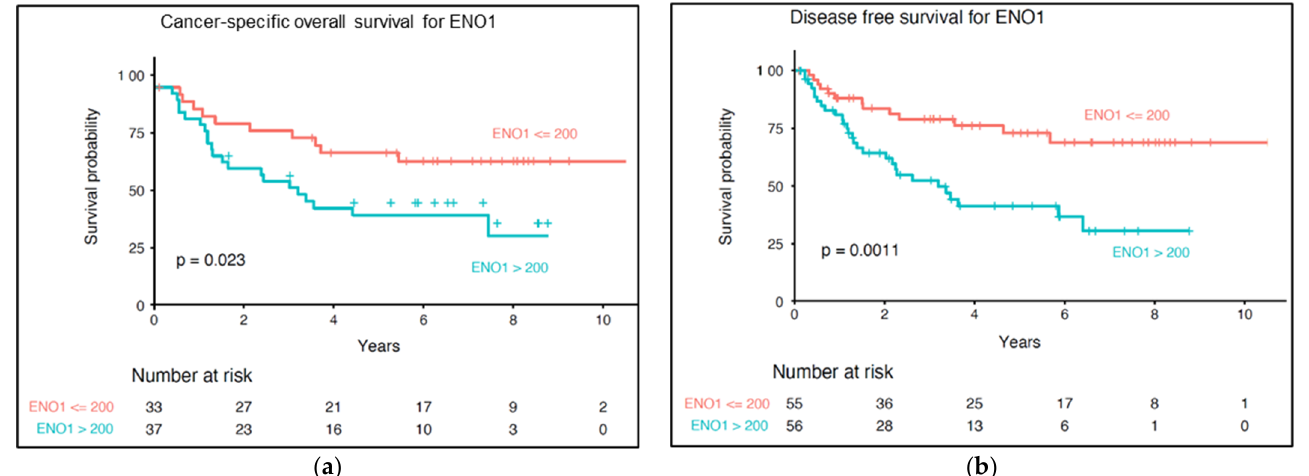
Figure 6. Kaplan–Meier analysis of the prognostic significance of ENO1 expression in cutaneous melanoma patients. Overexpression of ENO1 correlated with shorter cancer-specific overall survival ( a ) and shorter disease-free survival ( b ). p levels of the log-rank test. The multivariable Cox regression model was created to test whether ENO1 expres- Table 3. Univariate Cox proportional hazards sion may be used as an independent prognostic factor. After adjustment for regional lymph node status (HR: 5.9, 95% CI: 3.1 − 11.0, p < 0.001), high ENO1 expression was asso- ciated with shorter DFS (HR: 2.0, 95% CI: 1.0 − 4.0, p = 0.045) (Figure 7). When we compre- hensively analyzed all the most clinically important parameters (Breslow thickness, nodal status, and distant metastases), ENO1 did not reach statistical significance (Figure 7).